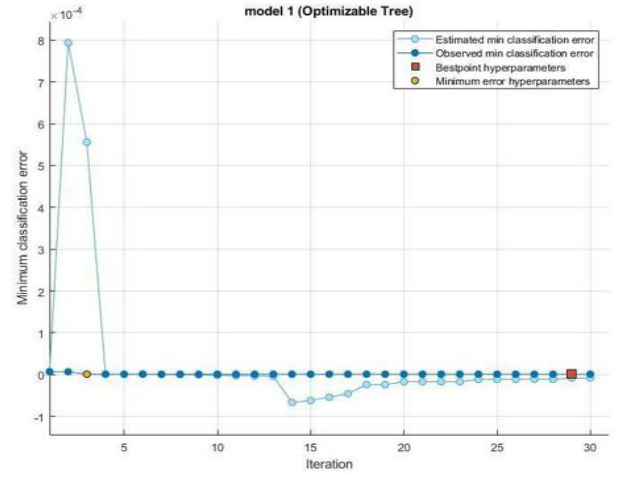
Fig. 6. Active wiretap minimum classification error of bayesian based optimized tree